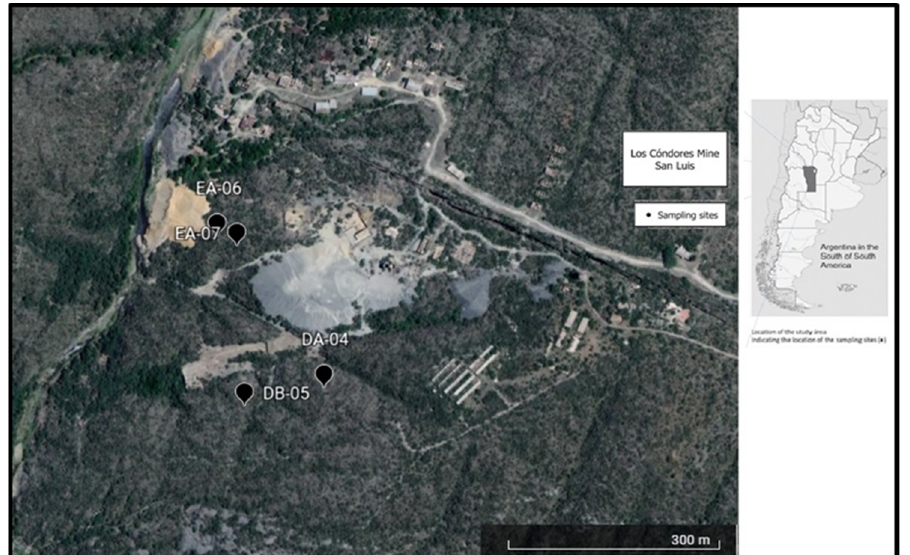
Figure 1. Geographical location of the Los Cóndores Mine in San Luis province (Argentina). Black points indicate the sampling sites under study.